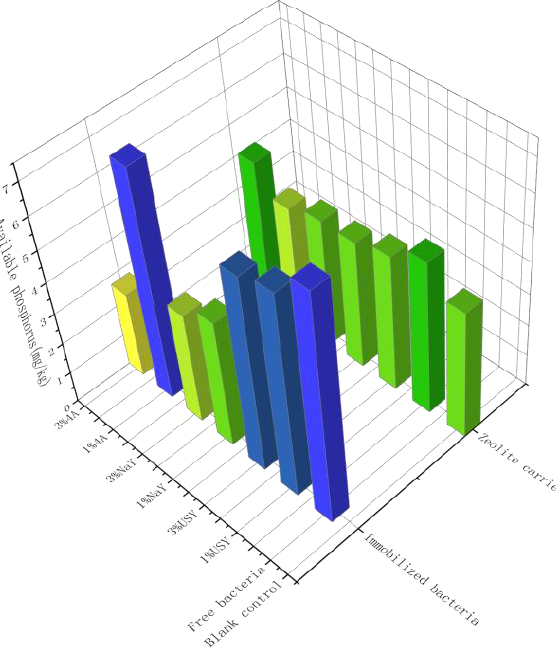
Figure 7. The effect of zeolite and bacteria on soil available phosphorus.